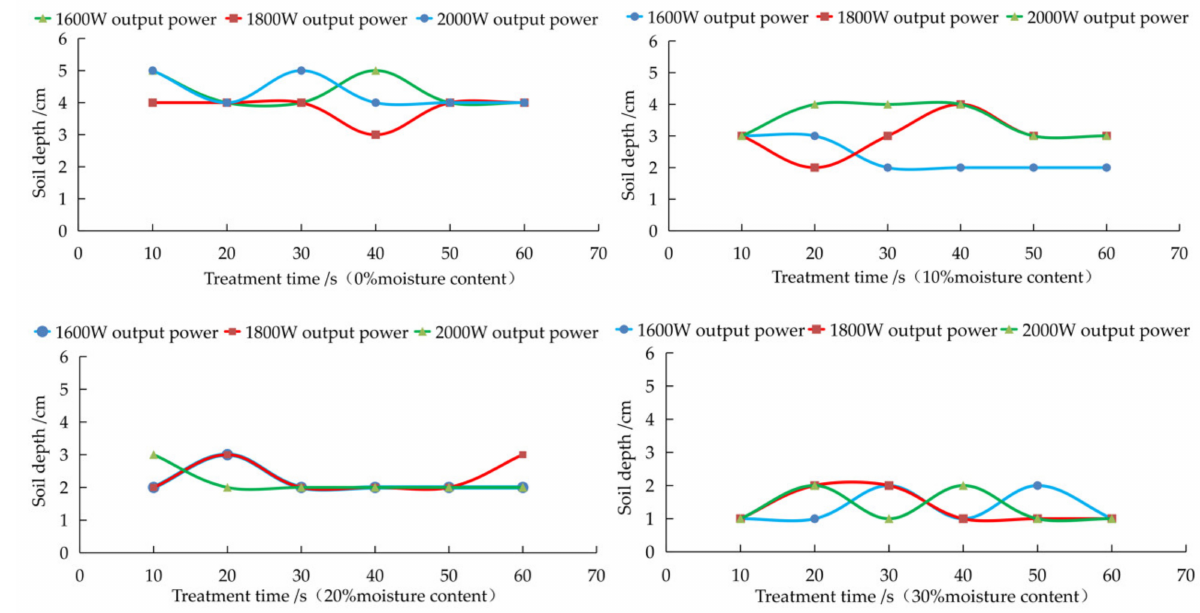
Figure 23. Location of the highest soil internal temperature after microwave